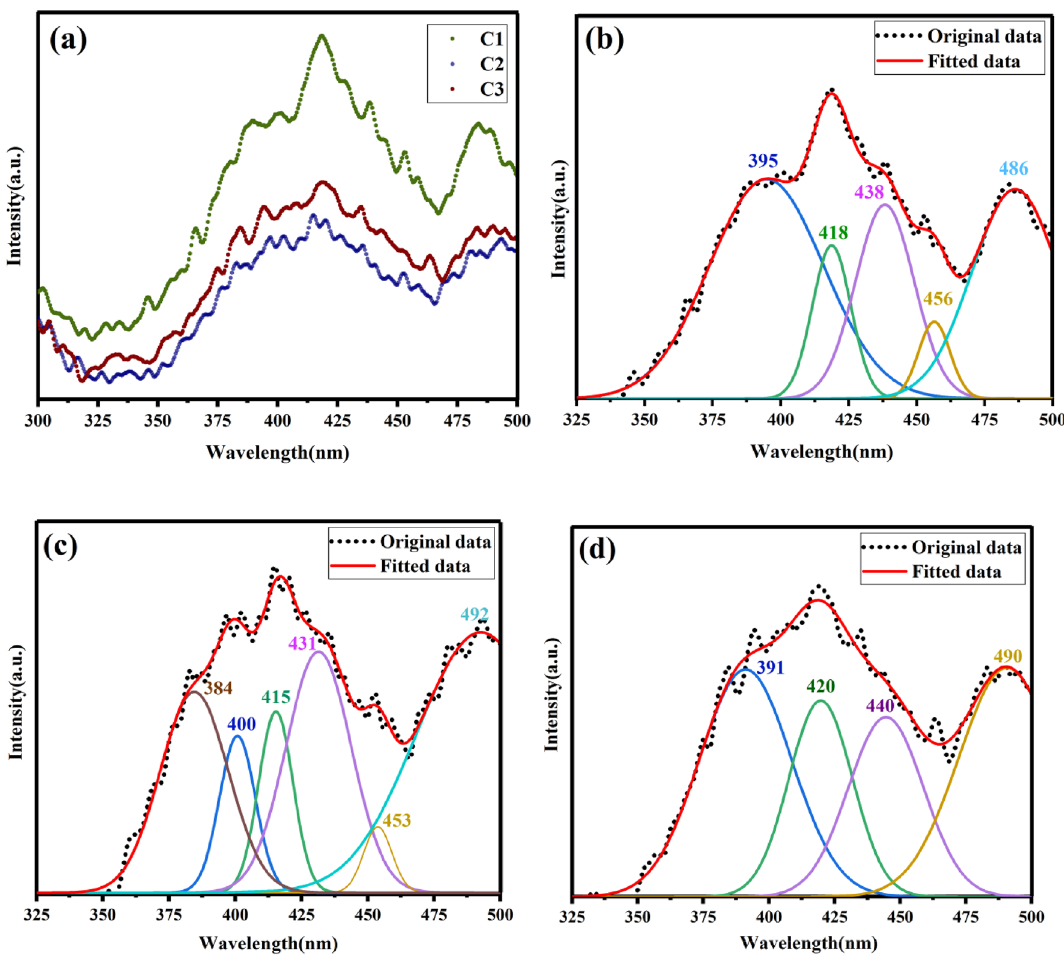
Figure 10. ( a ) The PL emission spectra of different samples. ( b ) PL spectrum deconvolution of the sample C1, ( c ) PL spectrum deconvolution of the sample C2, ( d ) PL spectrum deconvolution of the sampleC3.